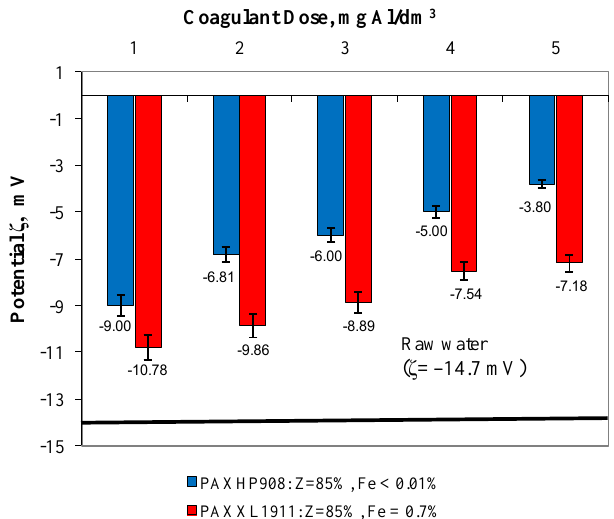
Figure 3. The effect of the type and dose of a coagulant on the change in zeta potential.